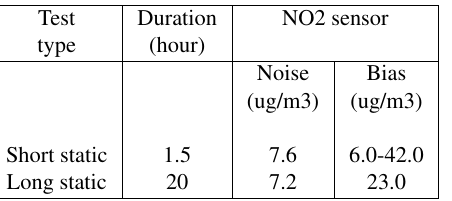
Table 1. NO2 concentration errors of the AirCrowd sensor node